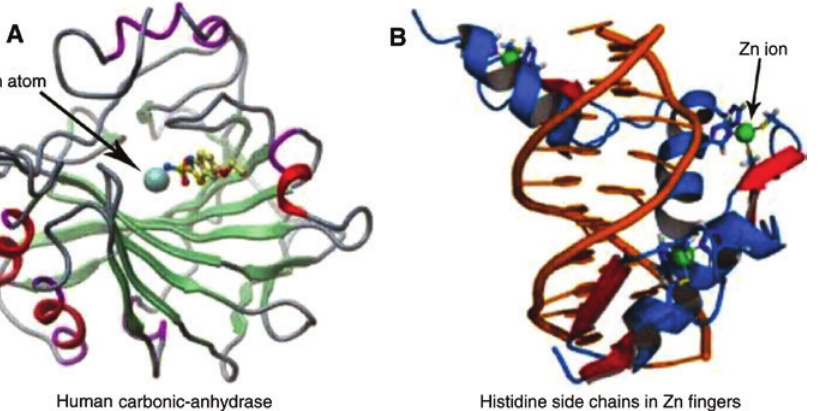
Figure 3: (A) Zn atom observable in the middle of the human carbonic anhydrase. (B) The two histidine side chains in Zn fingers, which coordinate with the Zn ion